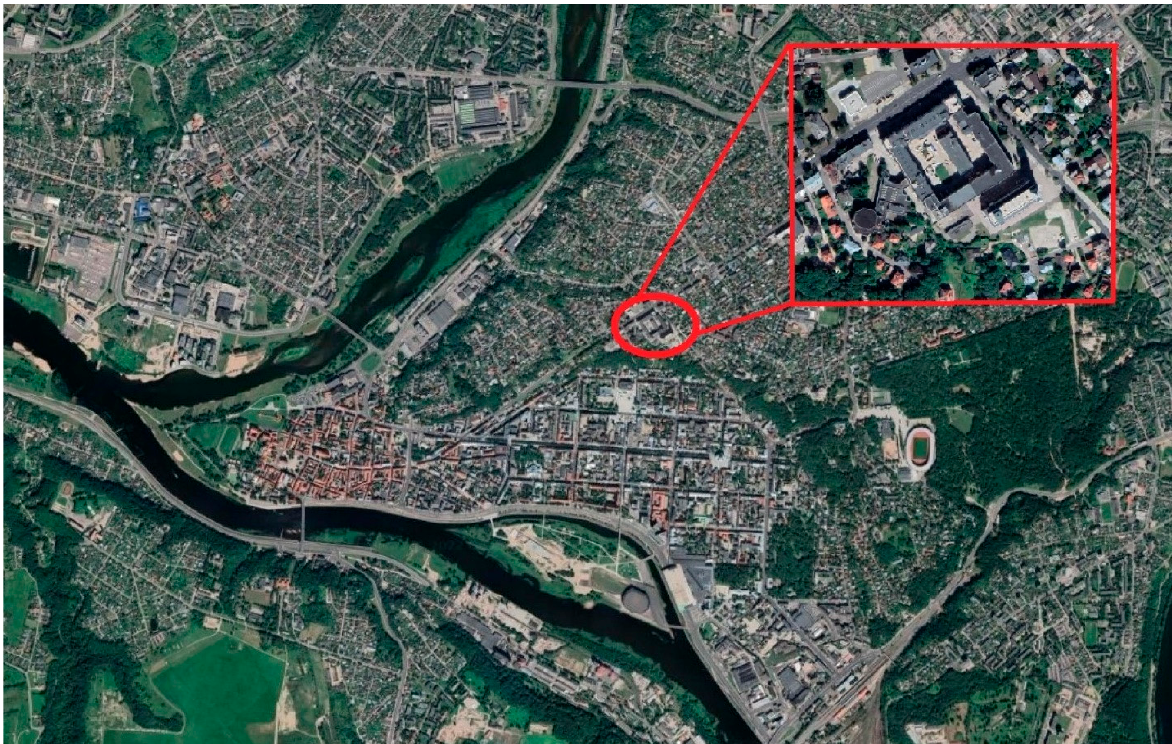
Figure 1. The location of the selected block in Kaunas city (source: Google Earth, modified by the author). the